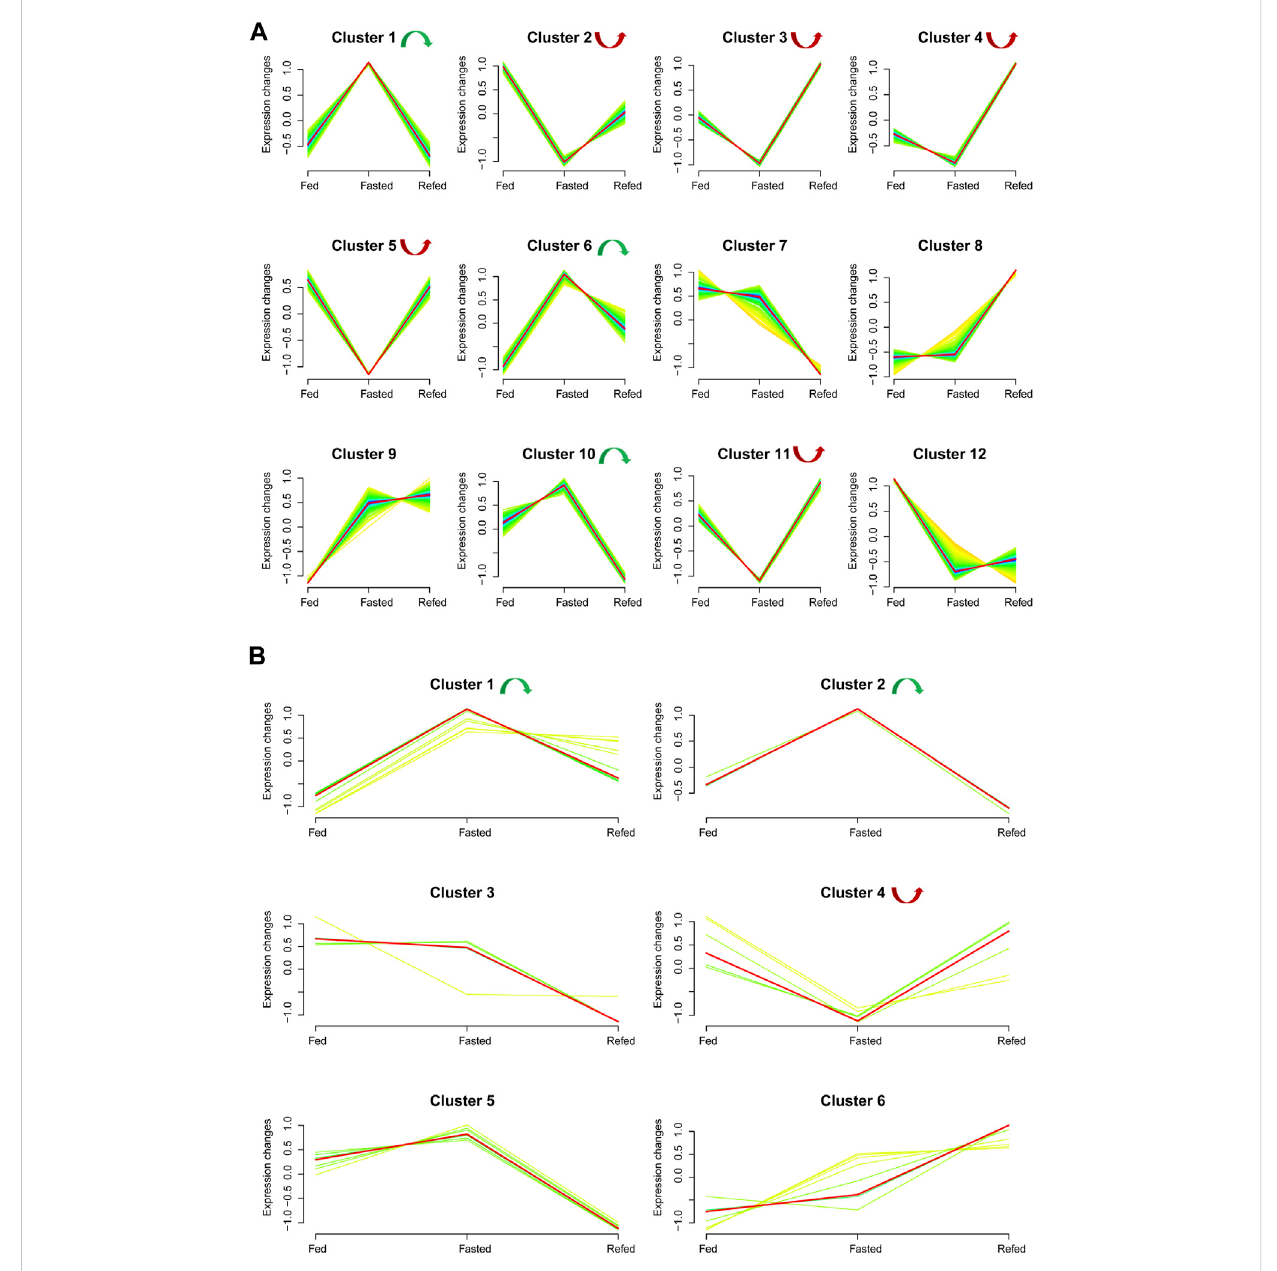
FIGURE 4 Expression trend analysis. (A) The results of expression trend analysis based on the union set of dysregulated mRNAs in fasted versus fed and refed versus fasted cohorts. Twelve mRNA clusters were detected. With a member.ship ≥ 0.3 used as the cutoff value, we identi fi ed eight signi fi cant mRNA clusters in the Fed – Fast – Refed cycle; three were upregulated and subsequently downregulated (1, 6 and 10) and fi ve were downregulated and subsequently upregulated (2 – 5 and 11). (B) Expression trend analysis based on the union set of dysregulated miRNAs in fasted versus fed and refed versus fasted cohorts.SixmiRNAclustersweredetected.Withamember.ship ≥ 0.3usedasthecutoff value,weidenti fi edthreesigni fi cantmiRNAclusters in the Fed – Fast – Refed cycle; two were upregulated and subsequently downregulated (1 and 2) and one was downregulated and subsequently upregulated